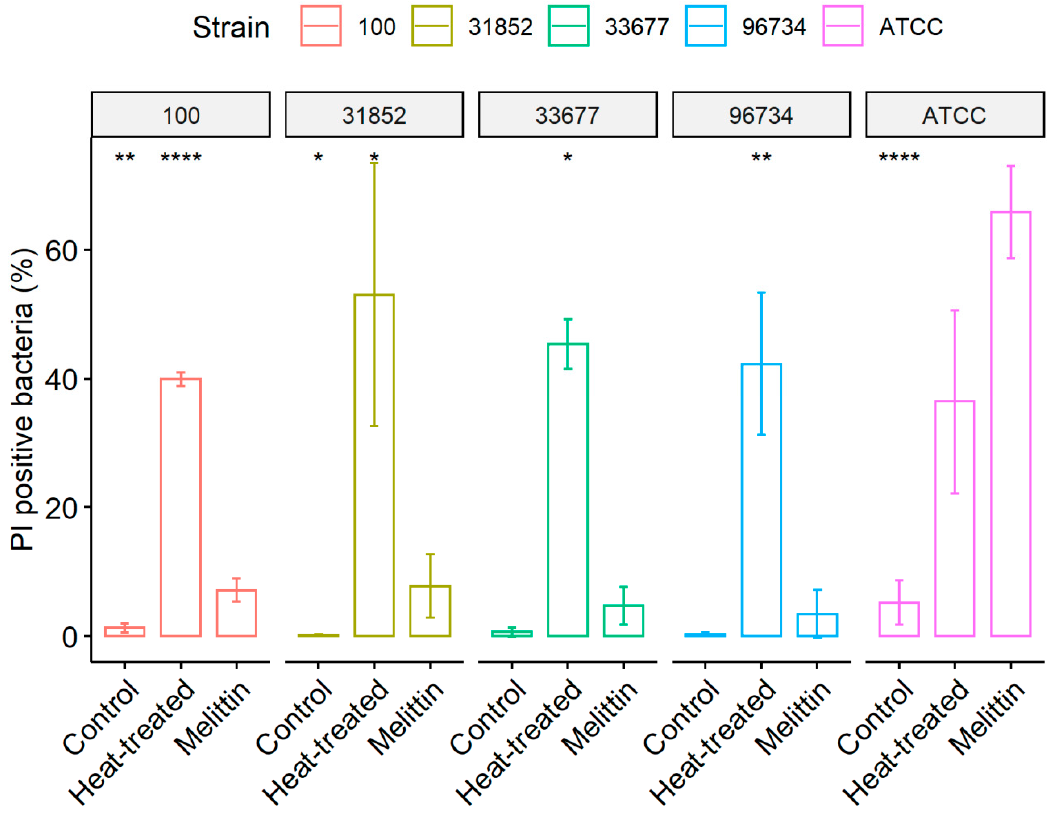
Figure 1. The action of melittin on biofilms of A. baumannii strains. Bacteria were allowed to grow in 96-well plates; after 24 h, the biofilms were treated with melittin (142 µg/mL) and after 2 h the biofilms were quantified by staining with crystal violet. Control represents untreated groups. Results represent the mean and standard deviation of at least three independent experiments. **** Statistically significant ( p < 0.001) using t- test.